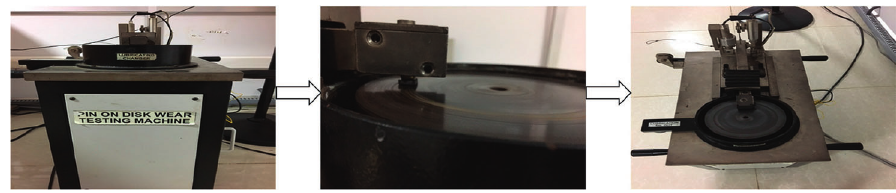
Figure 3: Pin on disc machine under the specimen test.